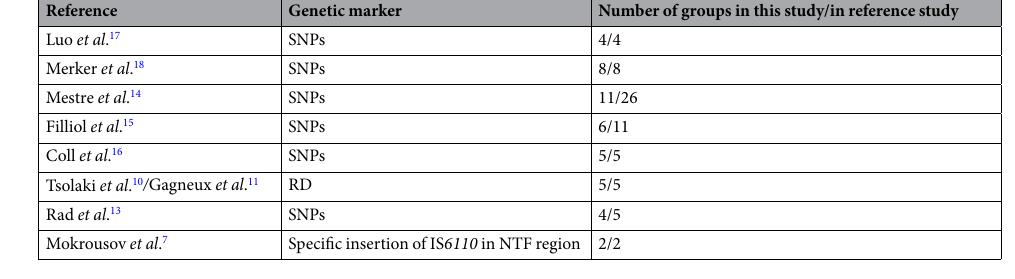
Table 1. Comparison of Typing